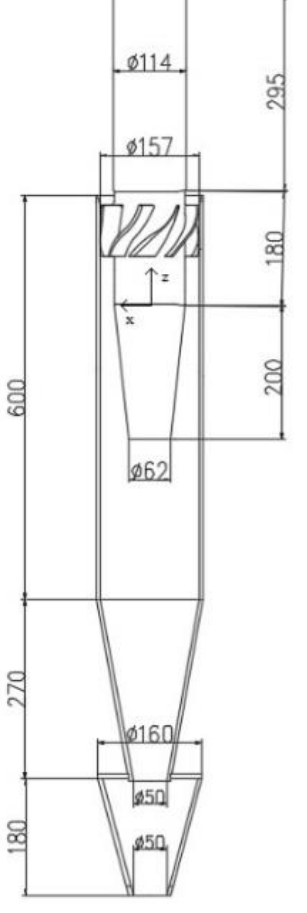
Figure 1. The axial flow cyclone separator size.